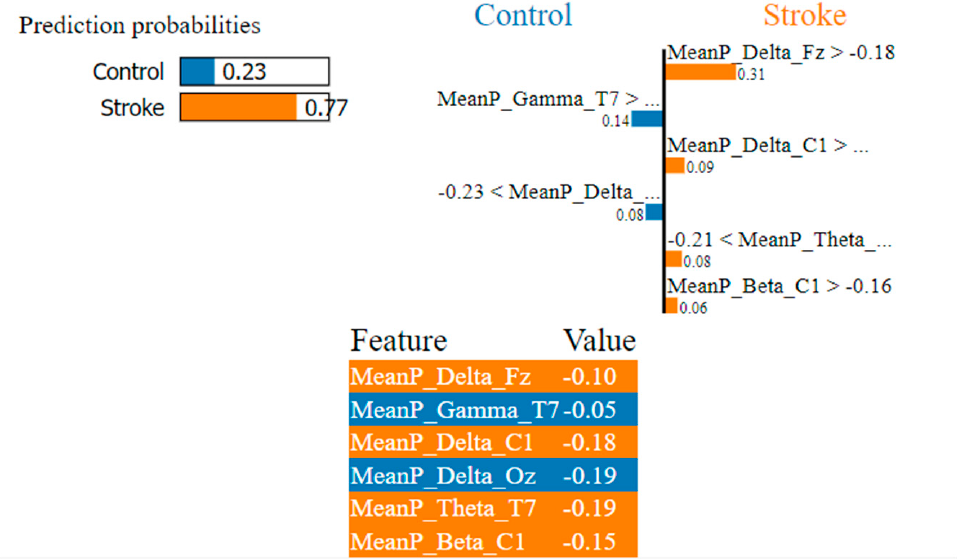
Figure 7. Visualization of the local contribution of EEG features through the LIME model in classifying a single test instance (predicted class = Stroke) using the XGBoost model. The orange-marked cells represent the features that contributed most to classifying the Stroke class.